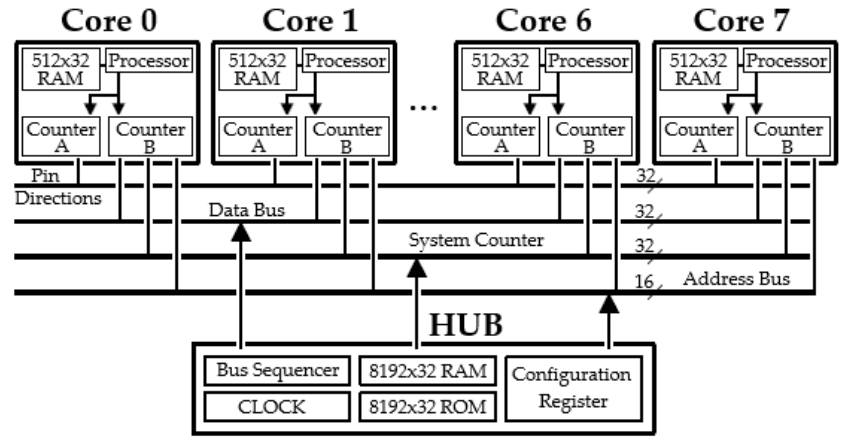
Figure 2. Propeller microcontroller block diagram.